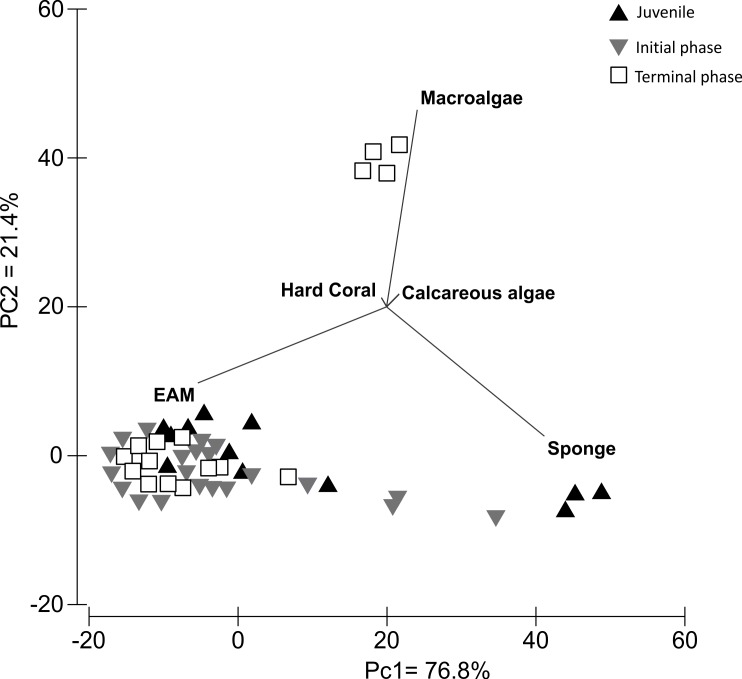
Principal components analysis with data clustered by types of substrata used as a food resource for S. zelindae at different life phases.